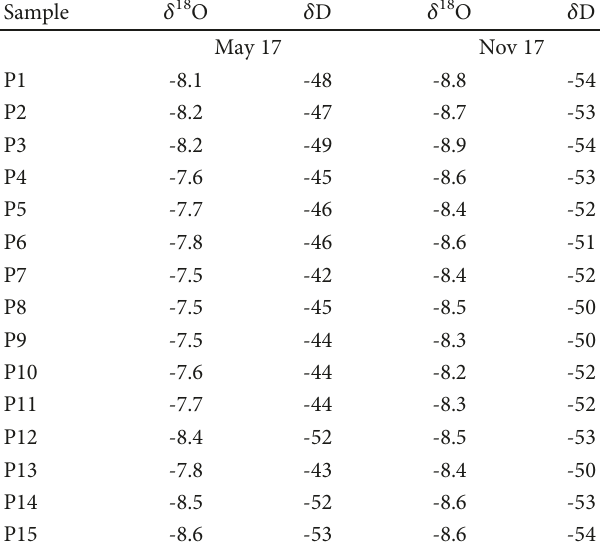
Table 5: Stable isotope composition of groundwater collected in two sampling